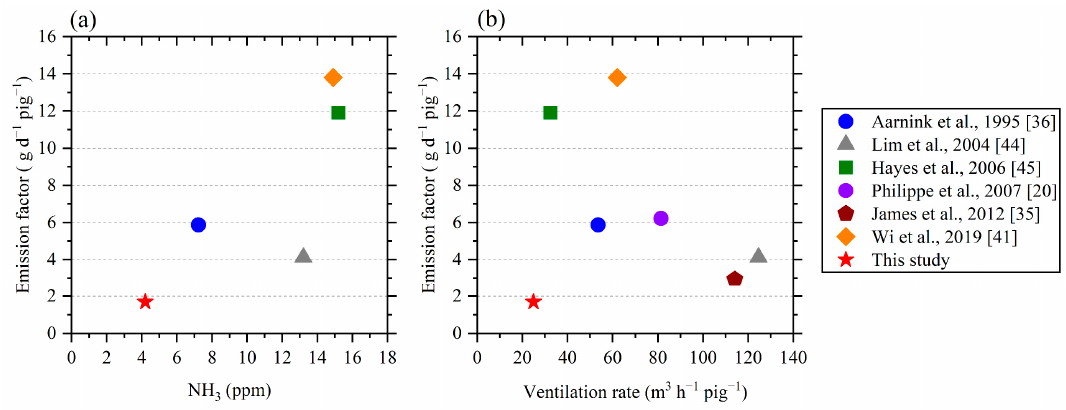
Figure 8. Scatter graphs of ammonia concentration, ventilation rate, and ammonia emissions data from previous studies and this study (Table 6). ( a ) Ammonia concentration vs. emission factor and ( b ) ventilation rate vs. emission factor.